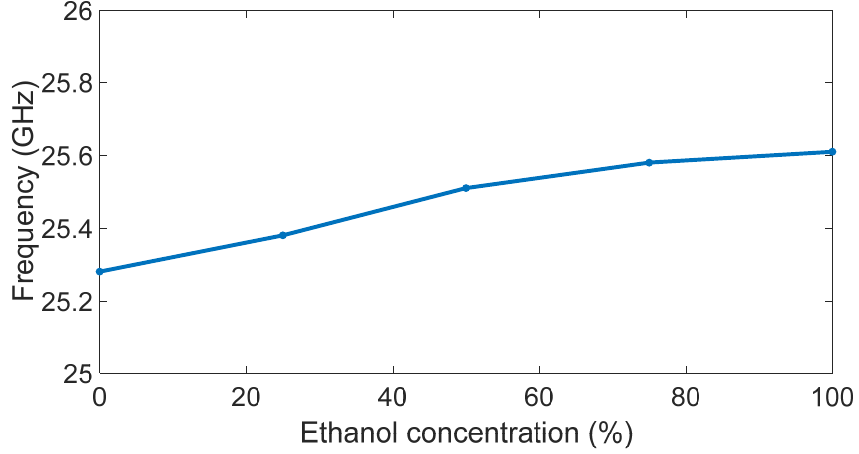
Figure 7. Antenna resonance frequencies versus ethanol concentration.